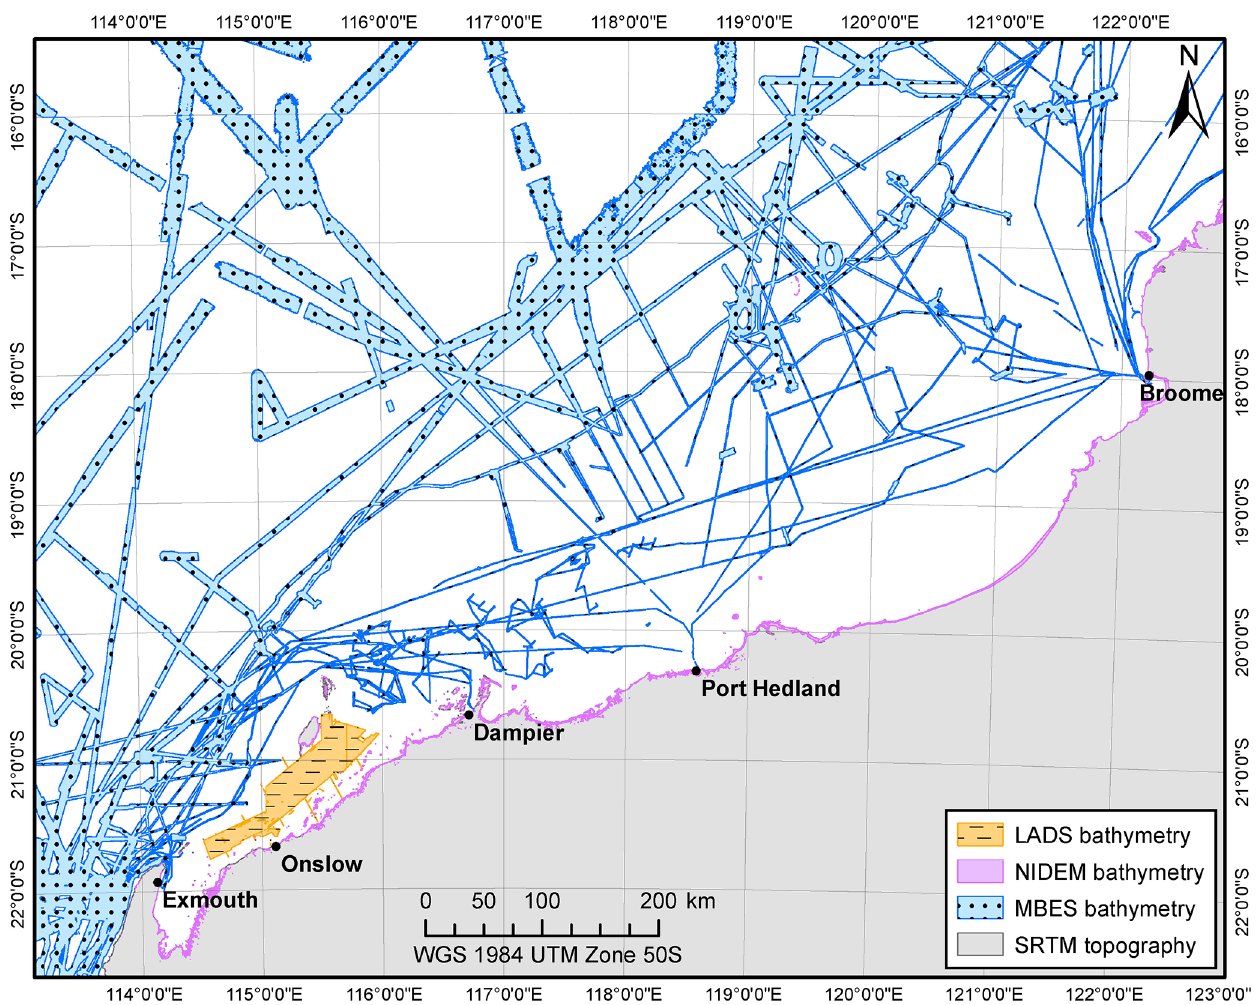
Figure 2. Public data available within the study area including Laser Airborne Depth Sounder (LADS) lidar bathymetry, the National Intertidal Digital Elevation Model (NIDEM; Bishop-Taylor et al., 2019), multibeam echosounder (MBES) bathymetry (Spinoccia, 2018), and Shuttle Radar Topography Mission (SRTM) data (Gallant et al., 2011). ENC navigation charts and the Australian Topography and Bathymetry Grid from Whiteway (2009) cover the entire